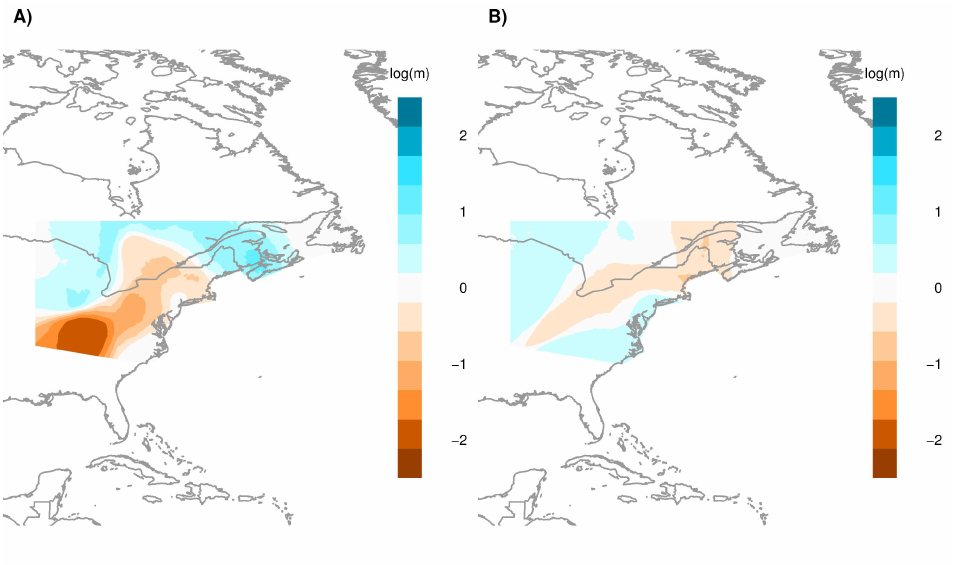
Figure 6. Estimated effective migration surfaces (EEMS) plot for P. destructans based on ( A ) SNP and ( B ) MSAT markers. Considering a maximum of 200 demes across the landscape, EEMS generates posterior mean migration rates (log10), indicating areas which have a higher (blue) or lower (orange) rate of migration (shown in blue) than expected under isolation by distance